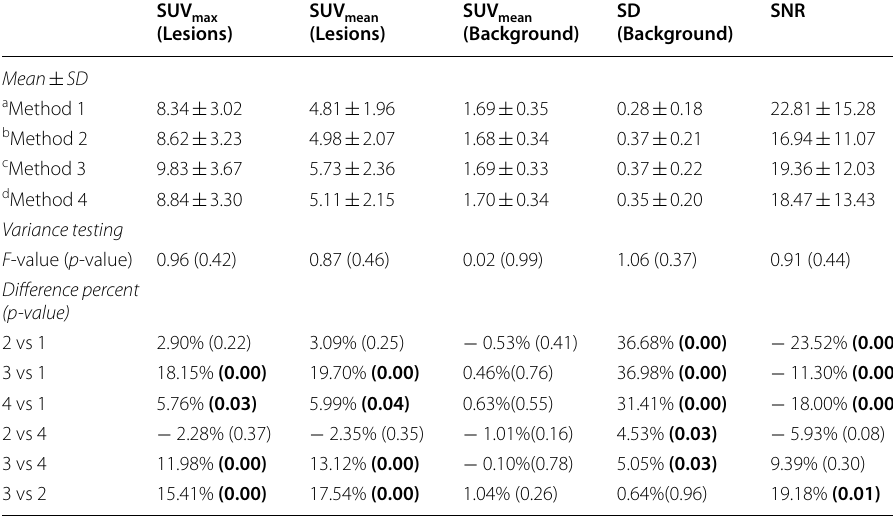
For obvious comparisons, the percent difference between pairs of groups was also calculated and shown p < 0.05 was considered a statistically significant difference between groups, which were shown in bold a The reconstruction of full data without respiratory gating